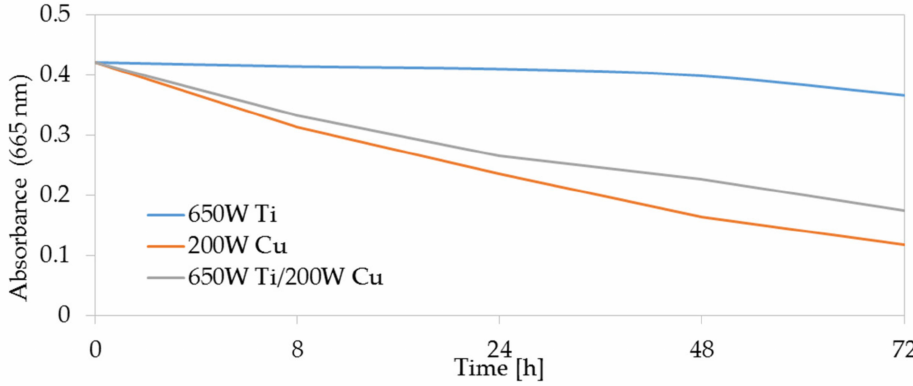
Figure 9. Comparison of absorbance after exposure of single-component Ti and Cu coatings and two-component TiO 2 + CuO coatings to